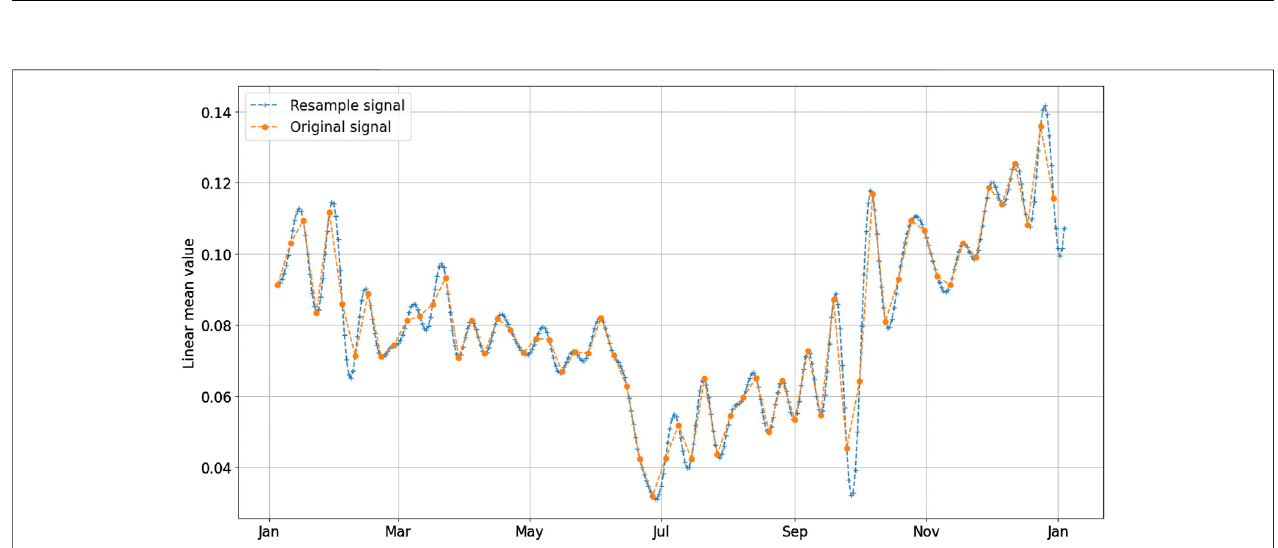
FIGURE 11 | Comparison of the original Sentinel-1 signal with the resampled signal after temporal interpolation (we show an example for the IA on the NW face of Grand Flambeau).